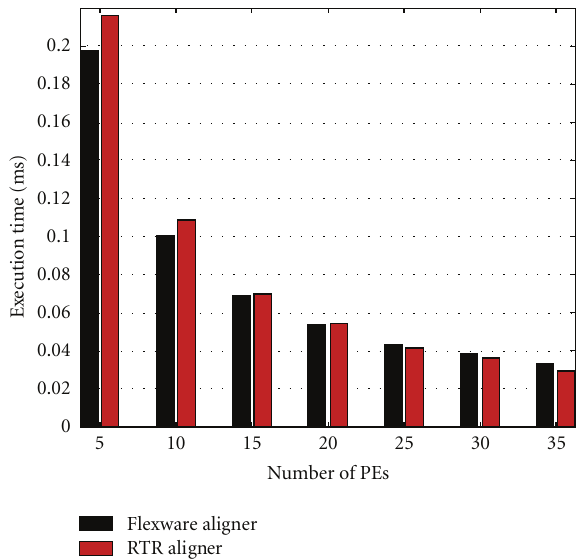
Figure 8: Execution time (ms) for both aligners, without reconfigu- ration overhead, based on measurements on the test platform when comparing a 188 to a 258 DNA sequence.